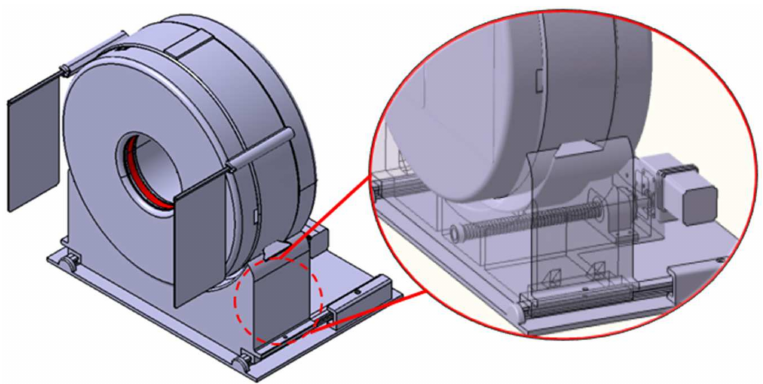
Figure 11. Fully assembled concept CT scanner